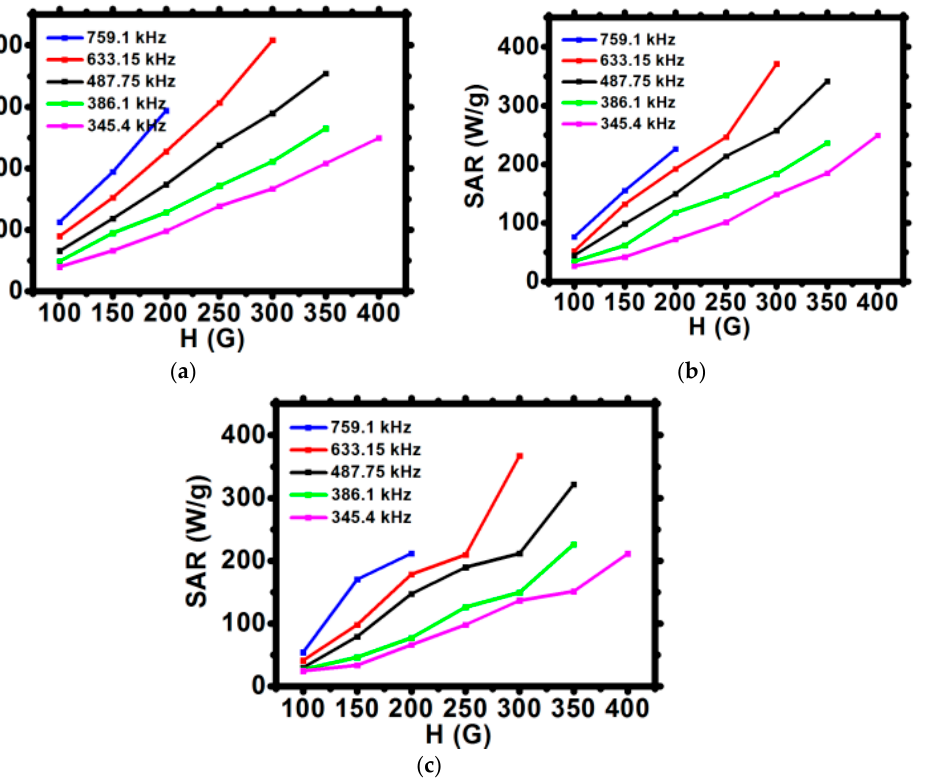
Figure 7. Dependence of the SAR for various frequencies of magnetic field in function of the amplitude of magnetic field H for ( a ) SPION, ( b ) SPION@CEPA, ( c ) SPION@CEPA@Tmab . of magnetic field H for ( a ) SPION, ( b ) SPION@CEPA, ( c )